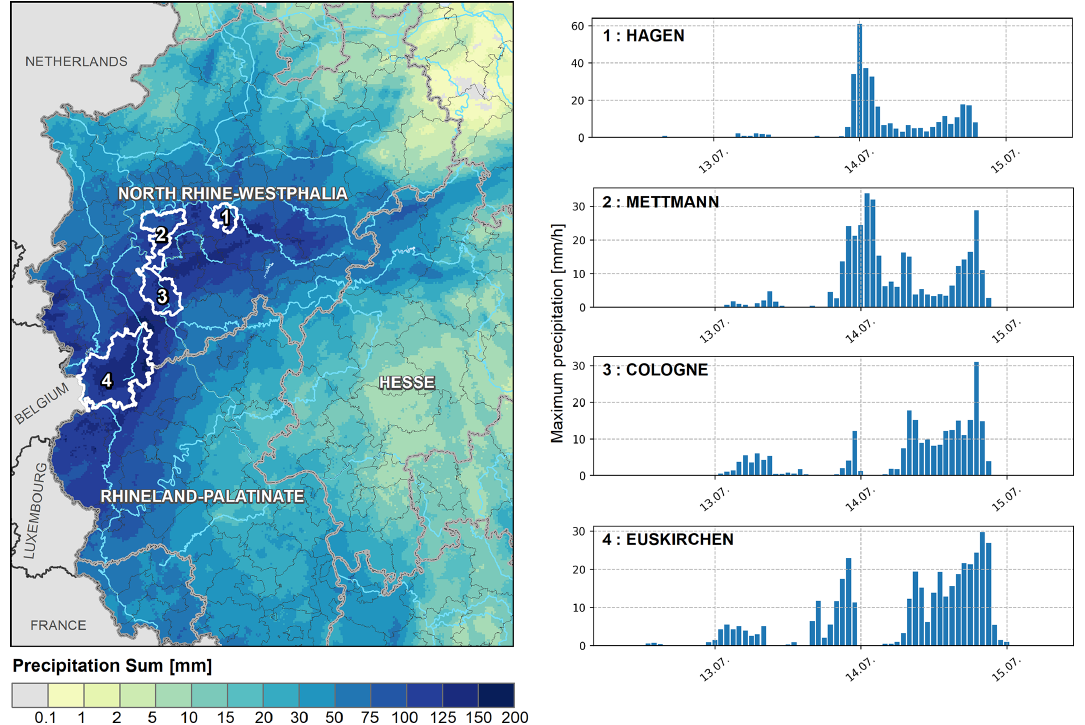
Figure 1. On the left is the accumulated rainfall of the precipitation event from 12 July 2021 at 05:50UTC to 15 July 2021 at 05:50UTC based on RADKLIM v2017.002 (Winterrath et al., 2018). On the right is the temporal development of the maximum hourly precipitation within the four districts of Hagen, Mettmann, Cologne and